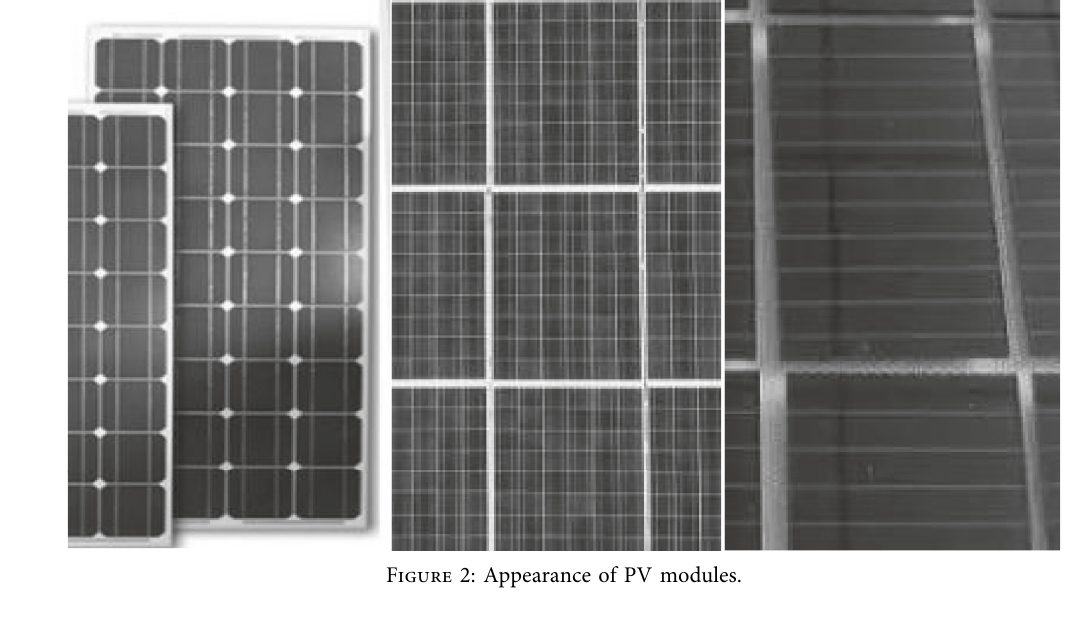
Figure 2: Appearance of PV